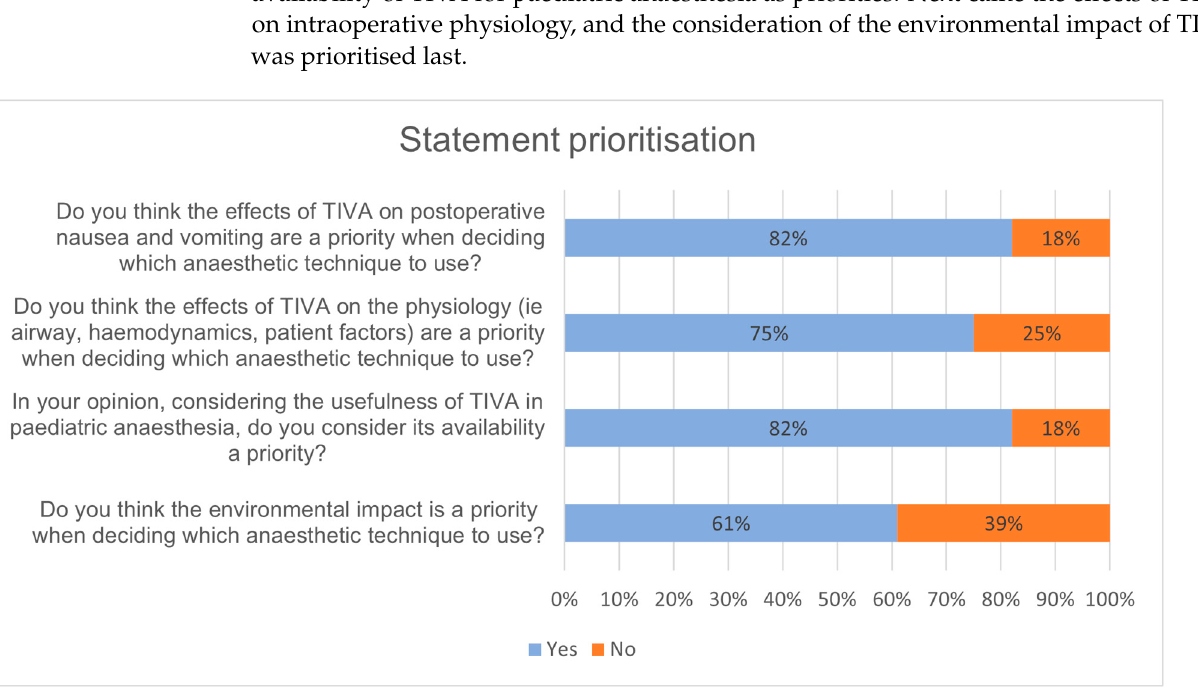
Figure 3. This graph shows the panellists’ prioritisation of the statements with a strong